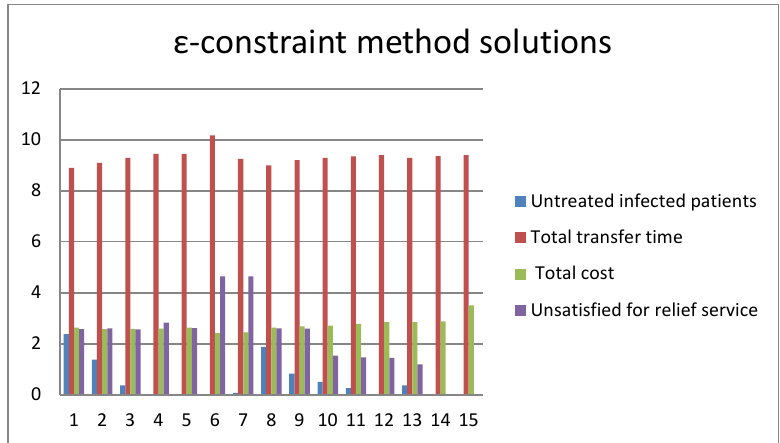
Figure 6. R esults for a small test problem by an ε -constraint algorithm. Figure 6. Results for a small test problem by an ε -constraint algorithm.